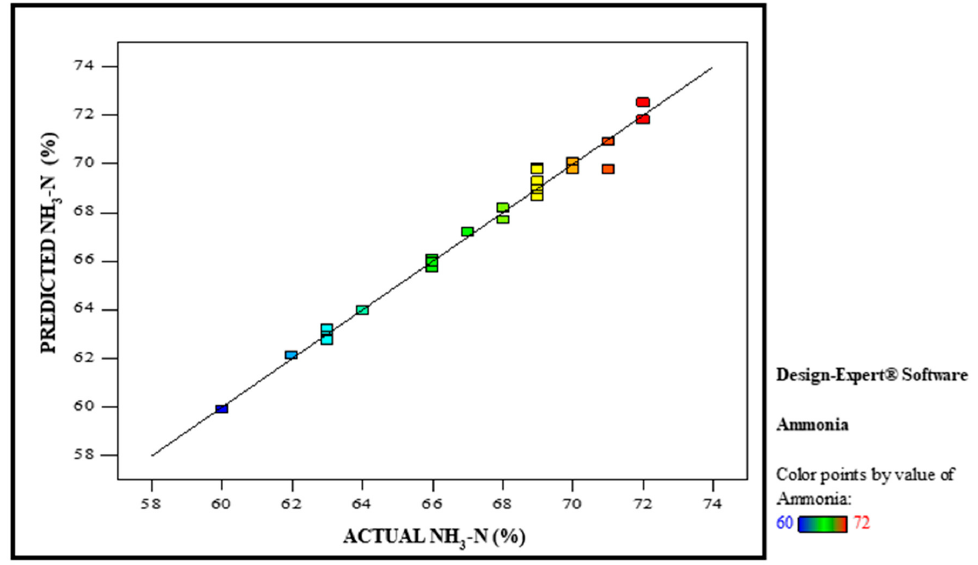
Figure 3. The plot of actual versus predicted values. Table 4. Analysis of variance (ANOVA) and quadratic model validation on NH 3 -N removal. Final Equation of Actual Factor on Percentage Removal of NH 3 -N